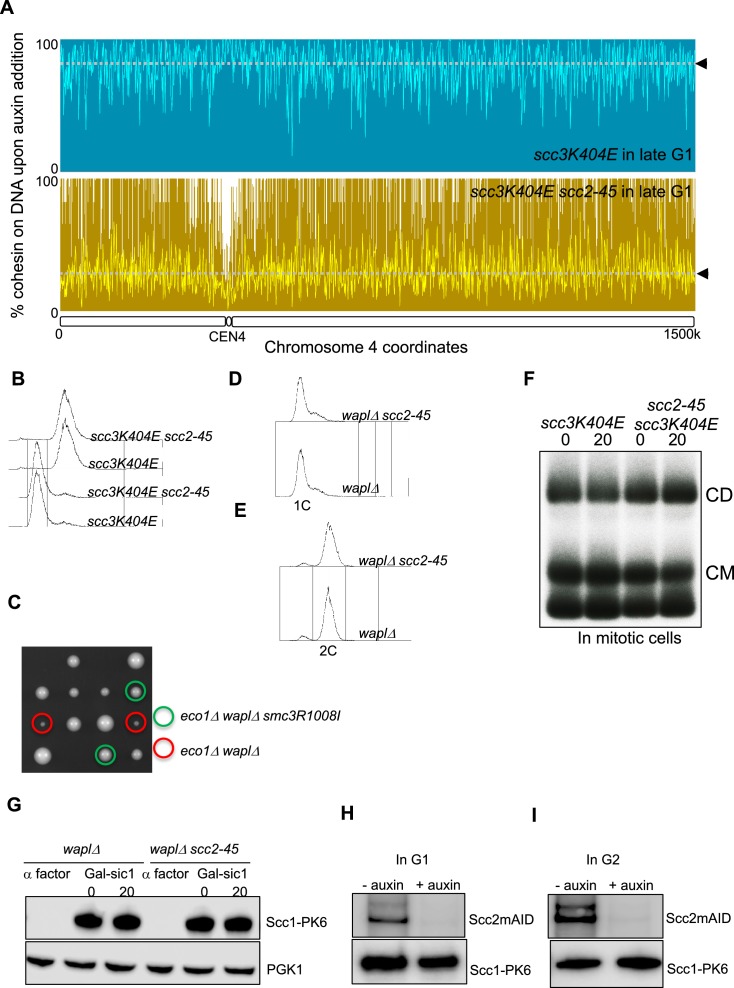
A Wapl-independent activity releases cohesin from chromosomes in G1 cells.(A) Data from Figure 1F is plotted to show the percentage of cohesin that remains on DNA upon Scc2 inactivation (after temperature shift) along the entire chromosome 4. The median cohesin level along the entire chromosome 4 (dotted line) is marked with arrowheads. (B) FACS analysis of the cultures described in Figure 1D (bottom two) and Figure 1—figure supplement 1F (top two). (C) Strain containing smc3R1008I mutation was crossed with an eco1Δ waplΔ strain and the resultant diploid analysed by tetrad dissection. The spores with eco1Δ waplΔ and eco1Δ waplΔ smc3R1008I are highlighted. (D) FACS analysis of strains grown in Figure 2A. (E) FACS analysis of strains grown in Figure 2B. (F) scc3K404E (K25313) and scc3K404E scc2-45 (K25316) 6C strains were arrested in G2 with nocadazole as described in Methods. The cultures were shifted to 37°C for 20 min, aliquots drawn before (0) and after (20) temperature shift (to inactivate Scc2) were subjected to mini-chromosome IP. Also see Figure 1—figure supplement 1B. (G) The cultures from experiment described in Figure 2A were analysed by western blotting with the indicated antibodies. (H) The Scc2-3XmAID strain described in Figure 2G was analysed by western blotting with anti-mAID antibody and anti PK antibody before and after auxin addition. (I) The Scc2-3XmAID strain described in Figure 2H was analysed by western blotting with anti-mAID antibody and anti PK antibody before and after auxin addition.